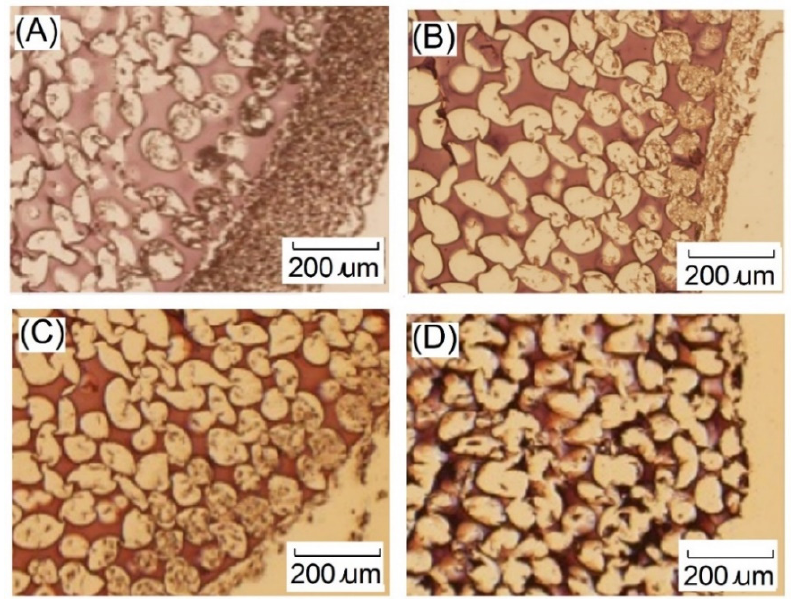
Figure 14. Images of hematoxylin and eosin staining showing growth of chondrocytes on gelatin- based hydrogel scaffolds after ( A ) 7 days, ( B ) 14 days, ( C ) 21 days, and ( D ) 28 days of dynamic culture. Dark blue-nucleus, light red-cytoplasm, intercellular substance, red-hydrogel scaffold. Scale bar represents 200 μ m.